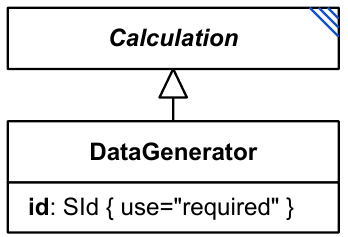
Figure 2.19: The SED-ML DataGenerator